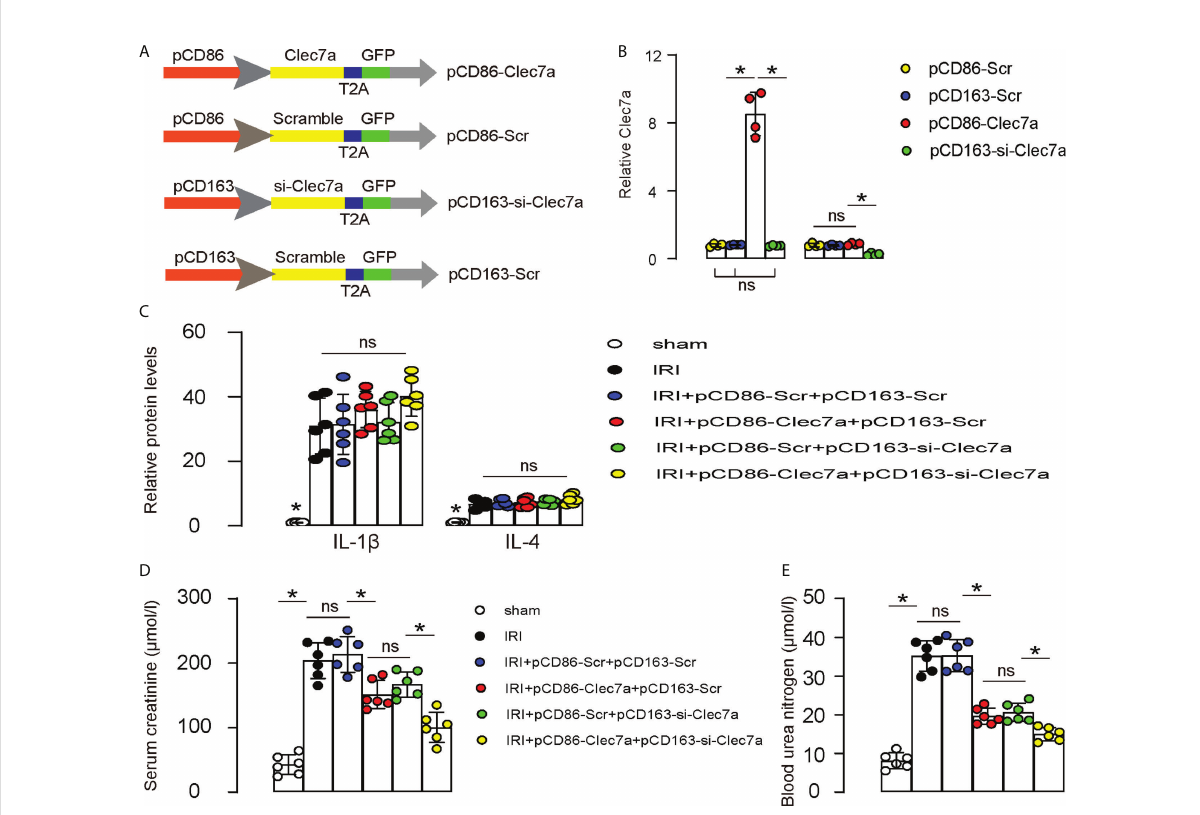
FIGURE 6 Combined expression of Clec7a in M1 macrophages and depletion of Clec7a in M2 macrophages signi fi cantly improve renal function after IRI- AKI. (A) Schematic to show generation of AAVs carrying Clec7a under a M1-speci fi c CD86 promoter (pCD86-Clec7a) and AAVs carrying si- Clec7a under a M2-speci fi c CD163 promoter (pCD163-si-Clec7a). Corresponding Scr controls were also generated. (B) ELISA for Clec7a levels in M1/M2 macrophages. (C – E) Mice were allotted into 6 groups. 1) Group 1: Sham, 2) Group 2: IRI, 3) Group 3: IRI and in situ administration of AAVs carrying pCD86-Scr and AAVs carrying pCD163-Scr, 4) Group 4: IRI and in situ administration of AAVs carrying pCD86-Clec7a and AAVs carrying pCD163-Scr, 5) Group 5: IRI and in situ administration of AAVs carrying pCD86-Scr and AAVs carrying pCD163-si-Clec7a, 6) Group 6: IRI and in situ administration of AAVs carrying pCD86-Clec7a and AAVs carrying pCD163-si-Clec7a. (C) ELISA for macrophage-derived cytokines, IL-1 b and IL-4. (D, E) Renal function was measured 24 hours after IRI, by serum creatinine (D) and by blood urea nitrogen (E) . *p<0.05. ns, no signi fi